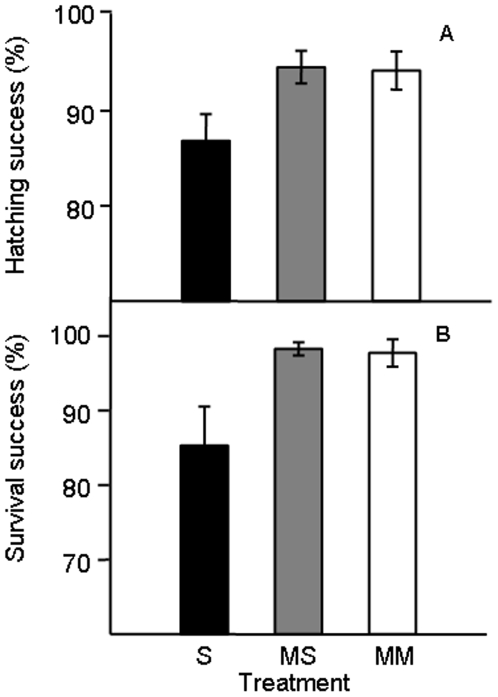
Mean (±S.E.) hatching success (Panel a) and larval survival (Panel b) of Galeolaria caespitosa offspring under single males (S), mixed-singles (MS) and multiple-males (MM) treatments.